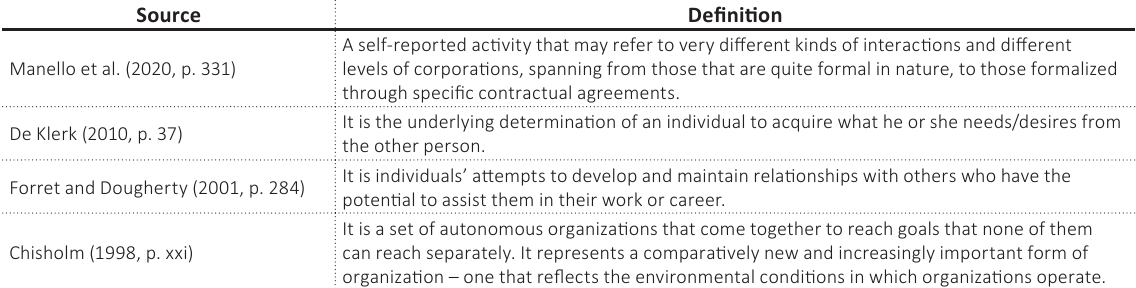
Table 1. Definitions of